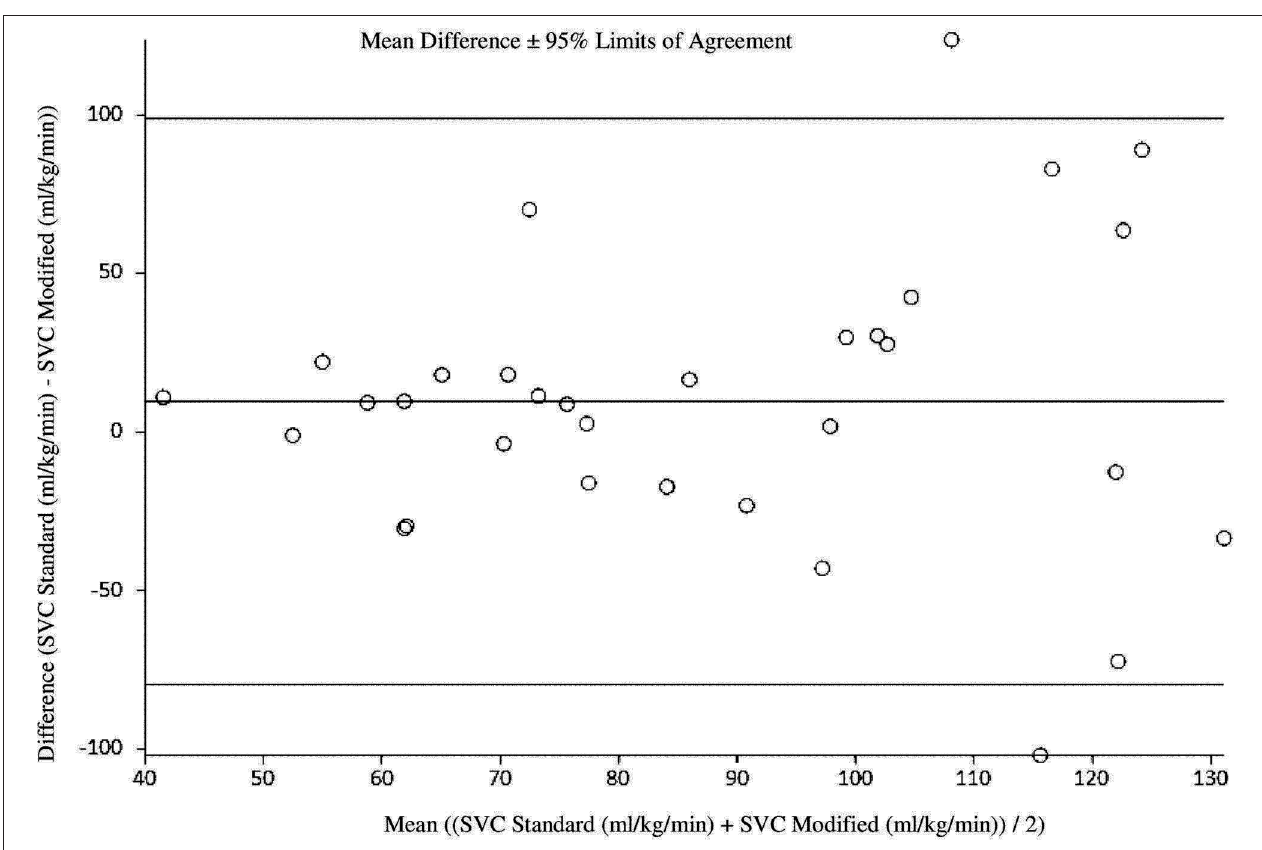
FIGURE 2 | Agreement between standard and modified Superior Vena Cava (SVC) flow measurement at 18h of age with mean difference and 95% limits of agreement.